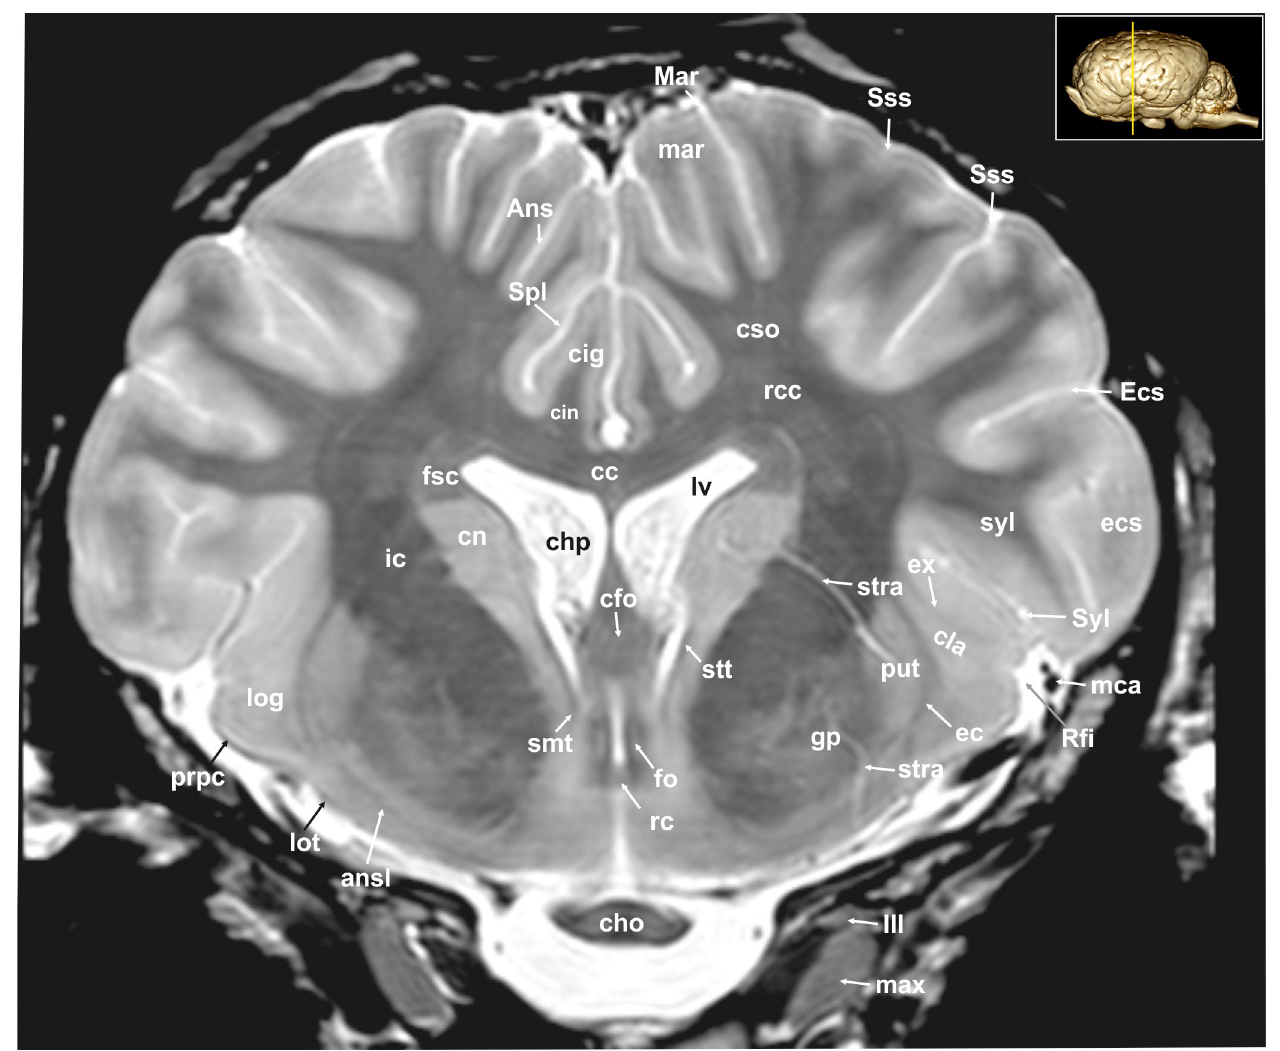
Fig 6. Transverse magnetic resonance image of the equine brain on the level of the rostral commissure. Ans: ansate sulcus, ansl: ansa lenticularis, cc: corpus callosum, cfo: corpus of fornix, cho: optic chiasm, chp: choroid plexus, cig: cingulate gyrus, cin: cingulum, cla: claustrum, cn: caudate nucleus, cso: centrum semiovale, ec: external capsule, Ecs: ectosylvian sulcus, ecs: esctosylvian gyrus, ex: extreme capsule, fo: fornix, fsc: subcallosal fasciculus, gp: globus pallidus, ic: internal capsule, log: lateral olfactory gyrus, lot: lateral olfactory tract, lv: lateral ventricle, Mar: Marginal sulcus, mar: marginal gyrus, max: maxillary nerve, mca: medial cerebral artery, prpc: prepiriform cortex, put: putamen, rc: rostral commissure, rcc: radiation of corpus callosum, Rfi: rhinal fissure, smt: stria medullaris thalami, Spl: splenial sulcus, Sss: suprasylvian sulcus, stra: striate artery, stt: terminal stria, Syl: sylvian fissure, syl: sylvian sulcus, III: oculomotor